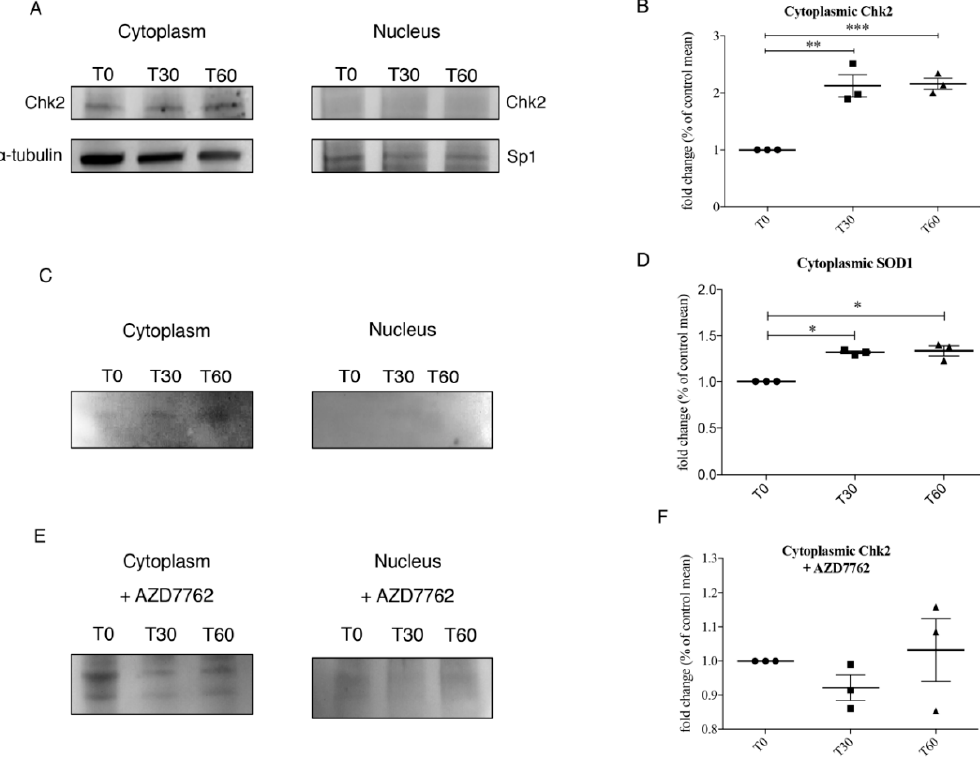
Figure 3. ( A , B ) Representative immunoblotting of cytoplasmic and nuclear Chk2 and quantification of Chk2 levels in the cytoplasmic compartment in SH-SY5Y at T0, T30 and T60. ( C , D ) Immunoprecipitation of Chk2 and quantification of cytoplasmic and nuclear SOD1 after oxidative stress. ( E , F ) The binding between Chk2 and SOD1 was further confirmed by immunoprecipitation also using AZD7762, a Chk1 and Chk2 inhibitor, to SH-SY5Y cells. After AZD7762 treatment no di ff erences were observed in both nuclear and cytoplasm compartment. Data were analyzed by ANOVA ( n = 3), followed by Newman-Keuls Multiple Comparison Test; * p < 0.05; ** p < 0.01 and *** p < 0.001.